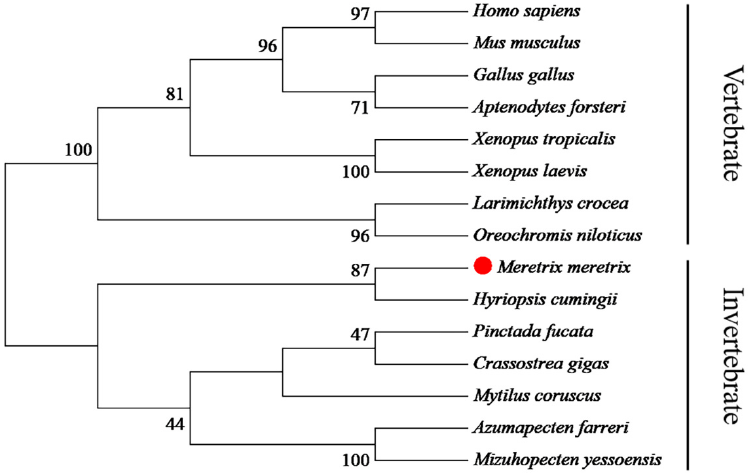
Figure 2. Phylogenetic tree analysis of Smad3 proteins between M. meretrix and other species.